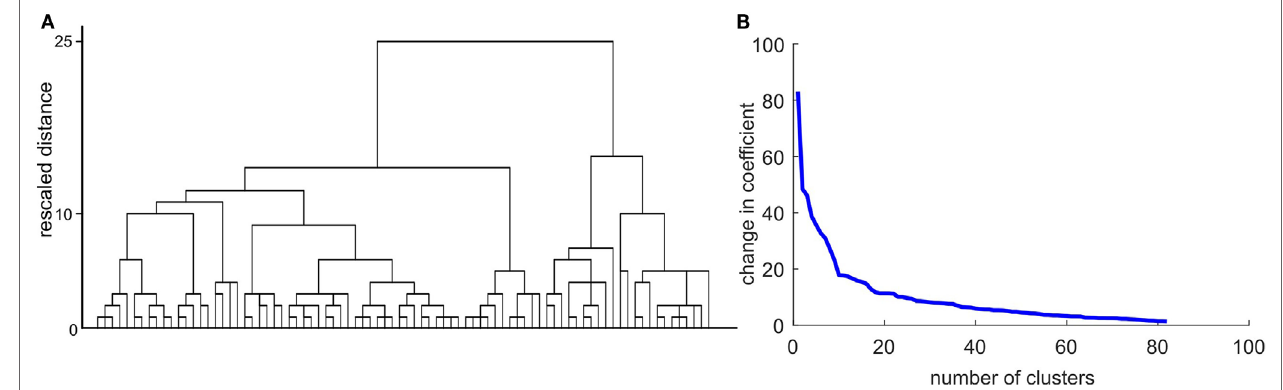
FigUre 4 | Results of the cluster analysis with intrinsic and task-related dynamic causal modeling parameters. (a) Dendrogram using Ward linkage. (b) The scree plot shows a potential inflection at n =